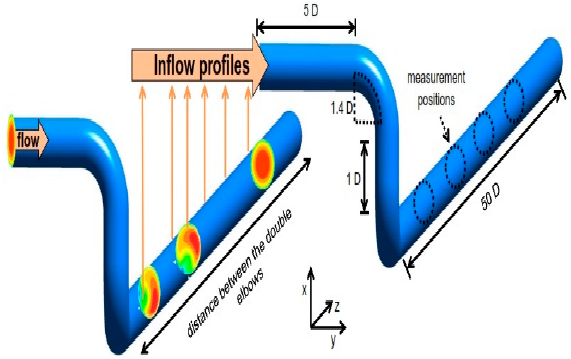
Figure 15. A hose with an elbow, and distance to the two nearest points.